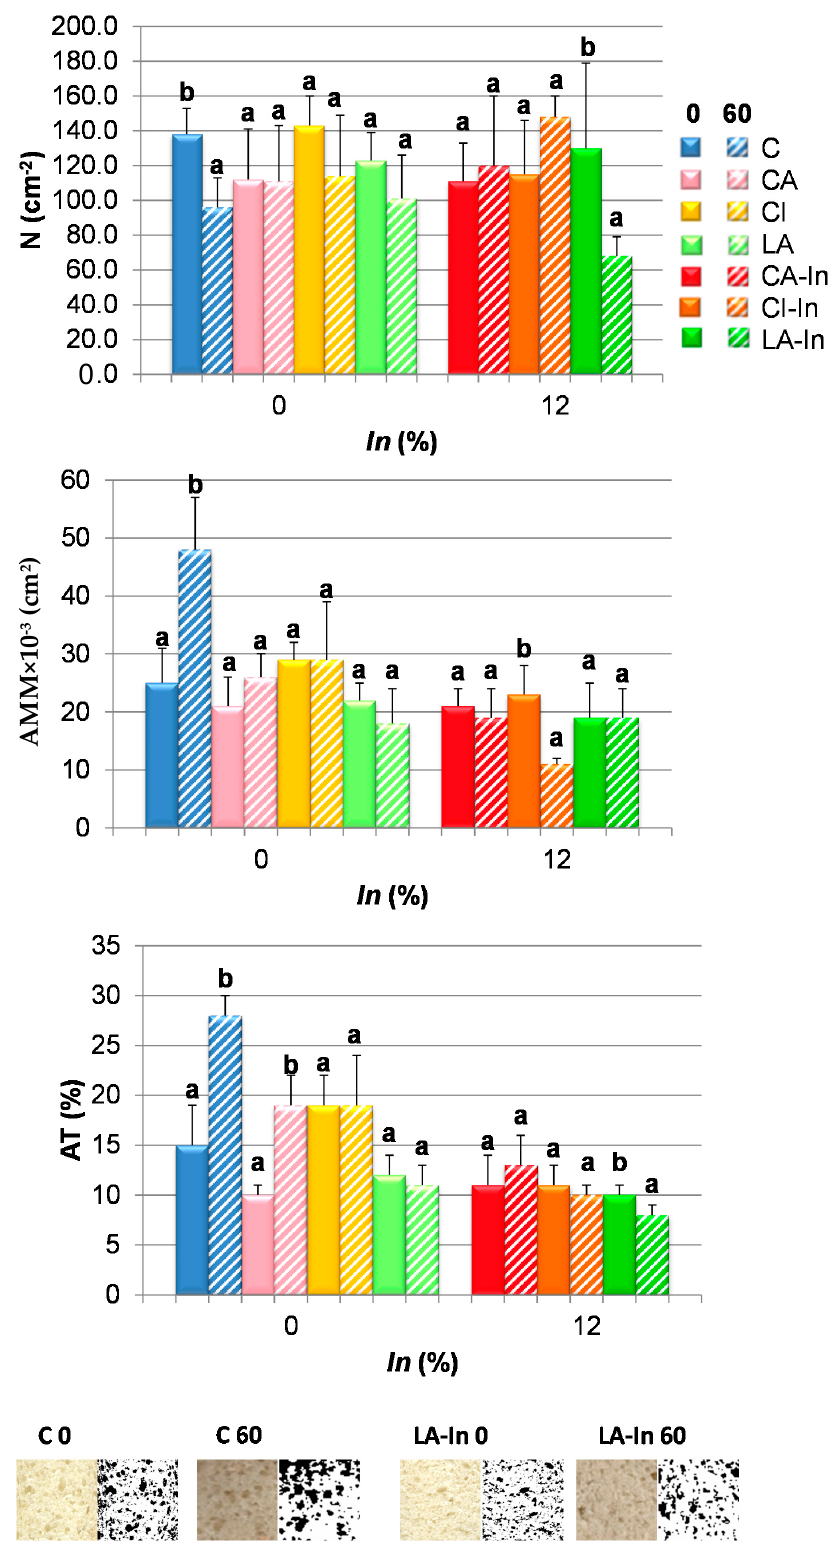
Figure 6. Crumb alveolate parameters: number of alveoli per area ( N ), mean area of alveoli ( AMM ) and air fraction ( AT ) of fresh and stored doughs at − 18 ◦ C for 60 days. Different letters in the same formulation indicate significant differences ( p < 0.05). Bars: mean ± standard deviation. Crumb and binary images of C0, C60, LA-In 0 and LA-In60